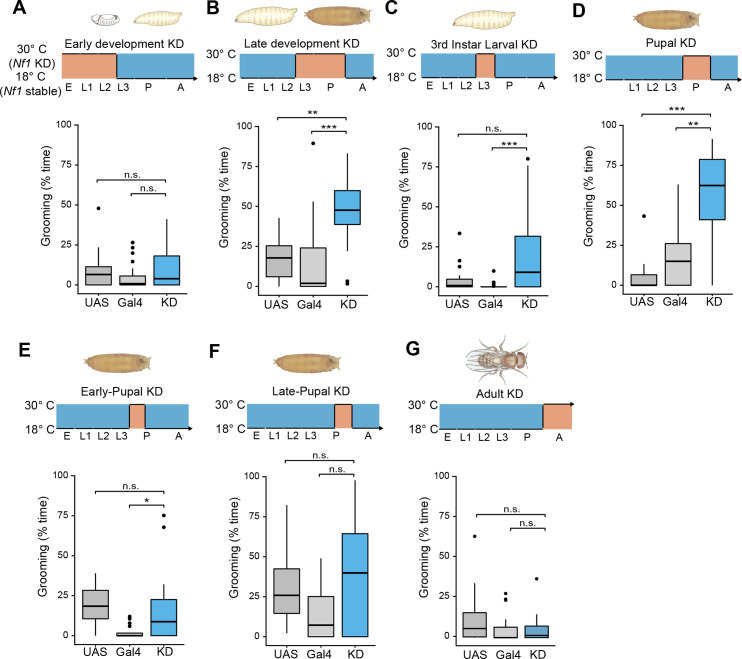
Excessive grooming results from the loss of Nf1 during a critical developmental window.Gal80ts was used to restrict knockdown (KD) of Nf1 with RNAi to different time windows during development and adulthood. (A-G) In each panel, elav-Gal4 > UAS-Nf1 RNAi, tub-Gal80ts (knockdown [KD]) is compared to UAS-Nf1 RNAi (UAS) and elav-Gal4 and tub-Gal80ts (Gal4) controls. n = 20. *p < 0.05, **p < 0.01, ***p < 0.001 (Dunn-Sidak). (A) Knockdown during embryo through larval L2 stage. p = 0.37 (Kruskal-Wallis). (B) Larval L3 and pupal stages. p < 0.001 (Kruskal-Wallis). (C) Larval L3 stage. p < 0.001 (Kruskal-Wallis). (D) Pupal stage. p < 0.001 (Kruskal-Wallis). (E) Early pupal stage. p < 0.001 (Kruskal-Wallis). (F) Late pupal stage. p = 0.05 (Kruskal-Wallis). (G) Knockdown in adulthood, following eclosion. p = 0.1 (Kruskal-Wallis).